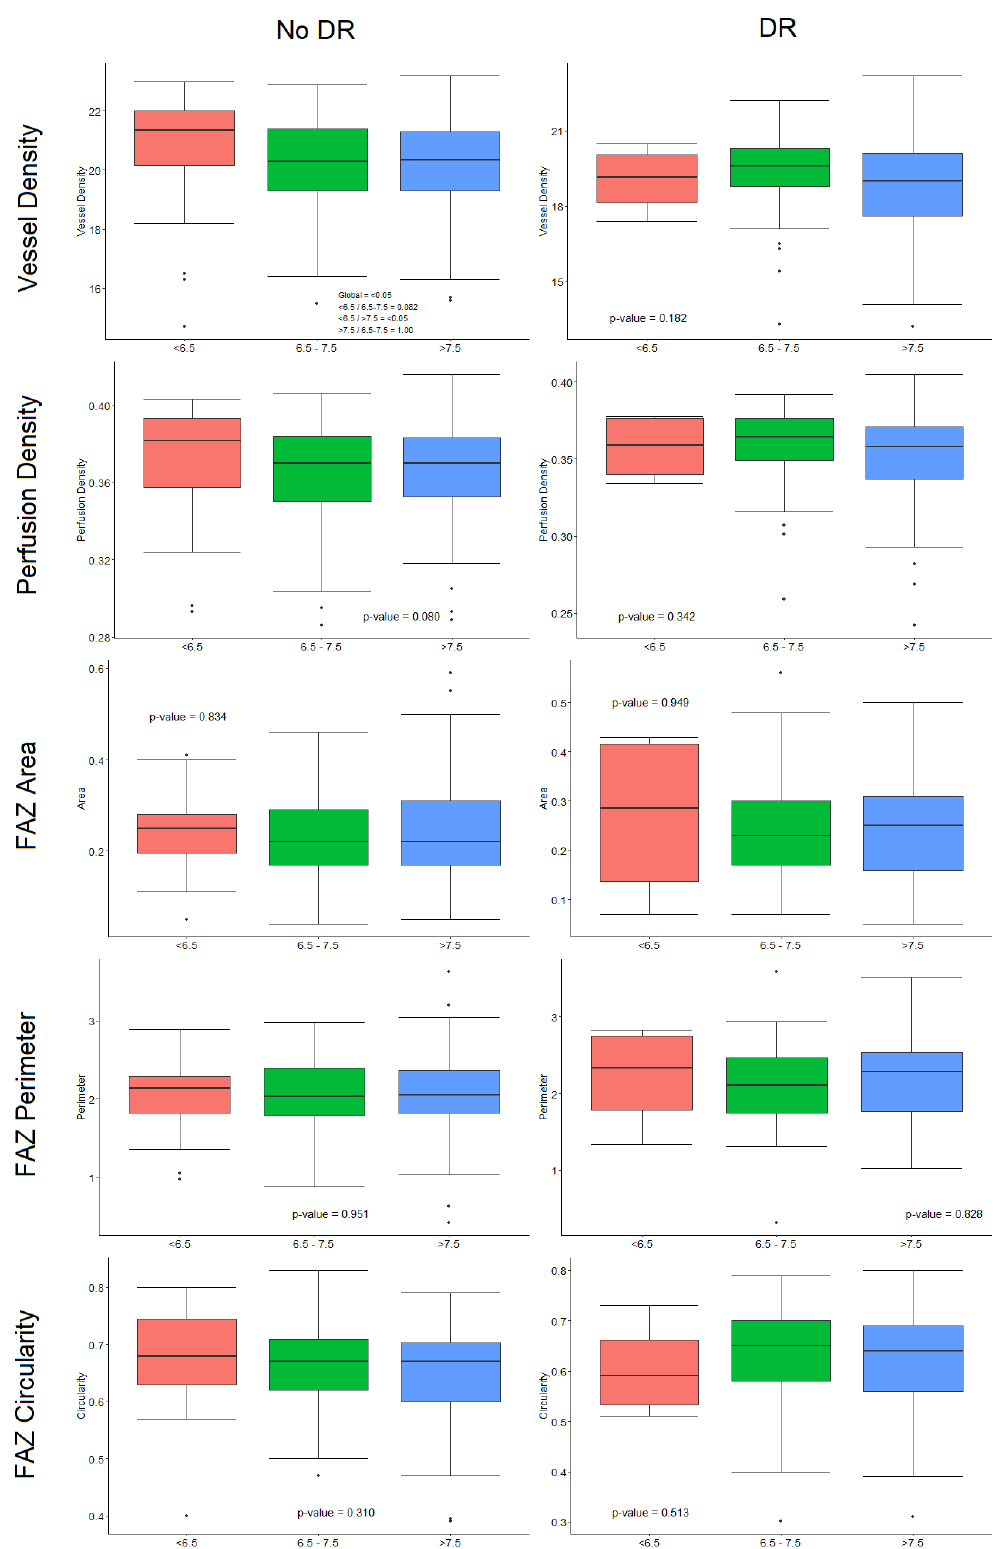
Figure 3. Optical coherence tomography angiography (OCTA) analysis by glycated haemoglobin (HbA1c) level subgroups in diabetes mellitus (DM) patients without and with diabetic retinopathy (DR). Left : OCTA parameter analysis in DM-no DR patients. Right : OCTA parameter analysis in DM-DR patients. ( p = values are adjusted by age, sex, signal strength index, diabetes mellitus duration, and axial length).